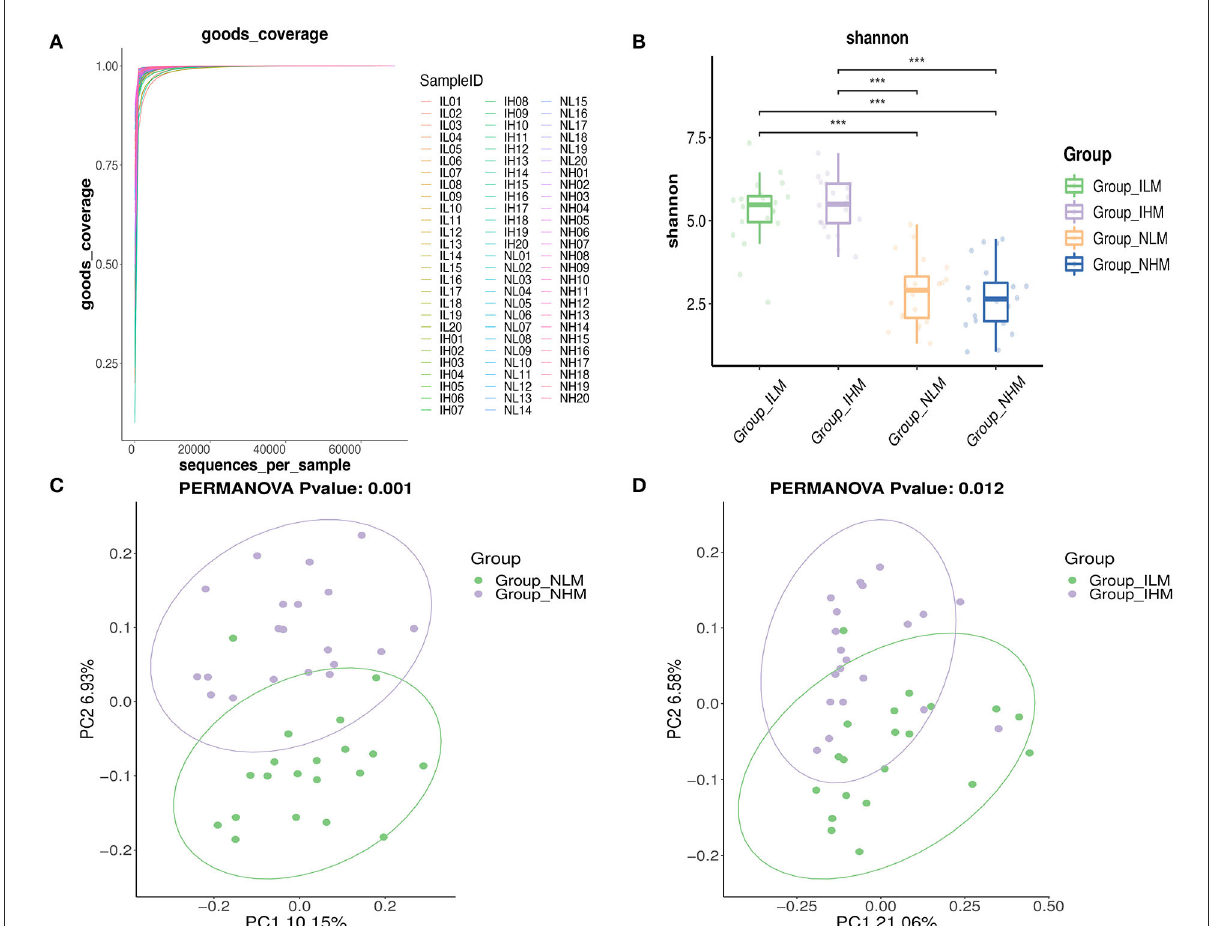
FIGURE3 Alpha and beta diversity analysis. (A) The Good’s Coverage. (B) The Shannon-Weaver index. (C,D) Each point in the PCoA represents a sample. Points in the same color are in the same group. The closer the points in the same group are, and the further the points to other groups are, the better the grouping effect is. *** P <